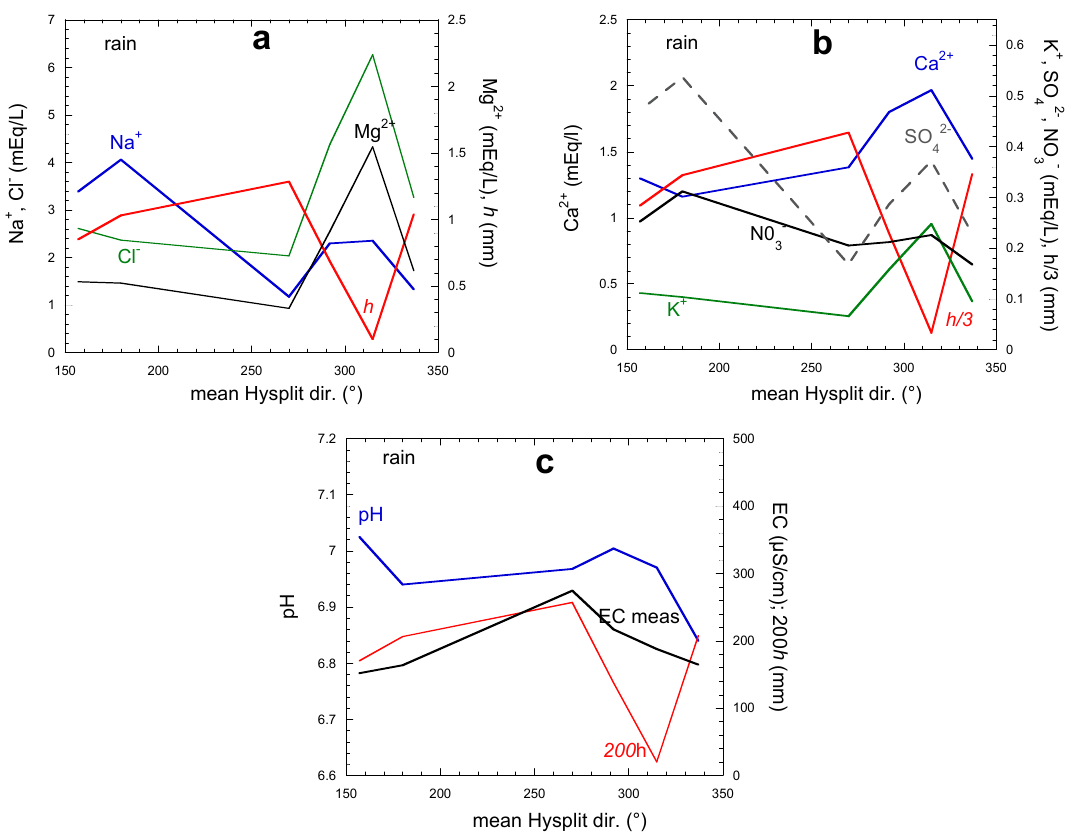
Figure 19. Correlated variations with the 24 h. mean air mass directions from Hysplit of main rain ions concentrations, electric conductivity EC, pH and dew volume per unit area h (mm). ( a ) Concentration of main ions of ocean origin (Na + , Cl − , Mg 2+ ) and h . ( b ) Concentration of the main ions of continental origin (Ca 2+ , K + , SO 42 − , NO 3 − ) and h . ( c ) EC, pH and h variation. All curves are smoothed fit of single values.